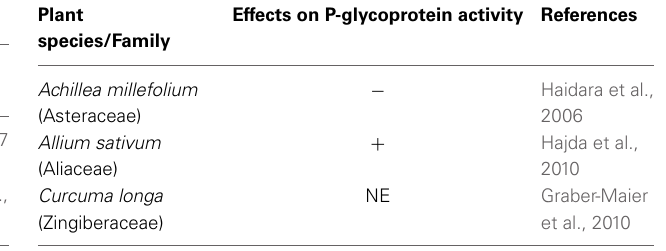
Table 9 | Medicinal plant species listed in RENISUS with reported effects of on P-glycoprotein